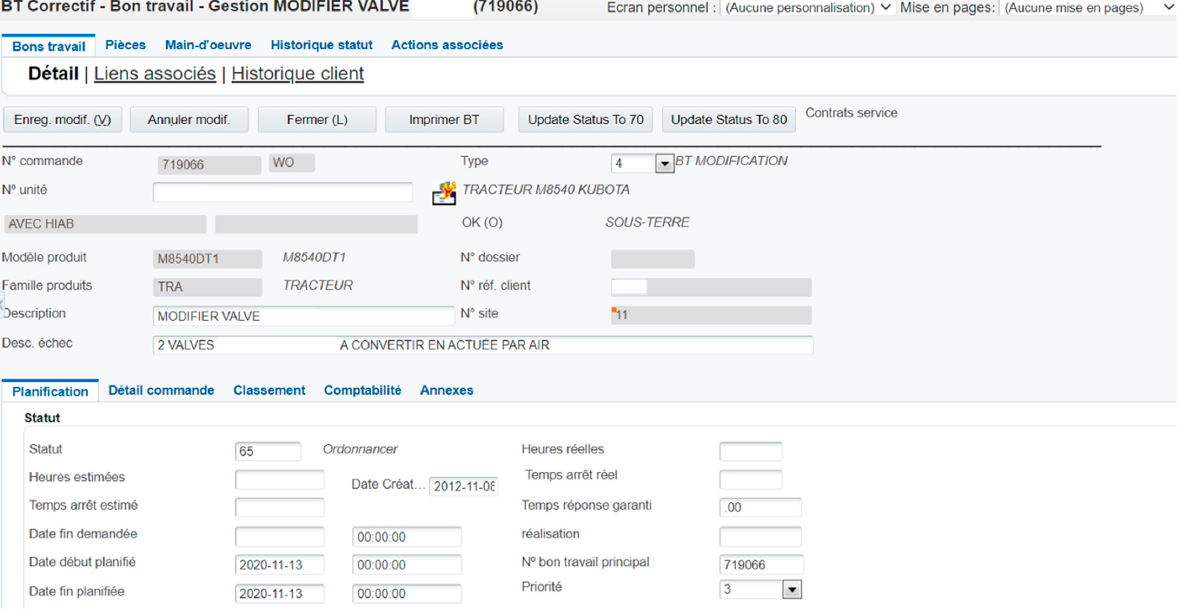
Figure A1. JDEdwards example work order.